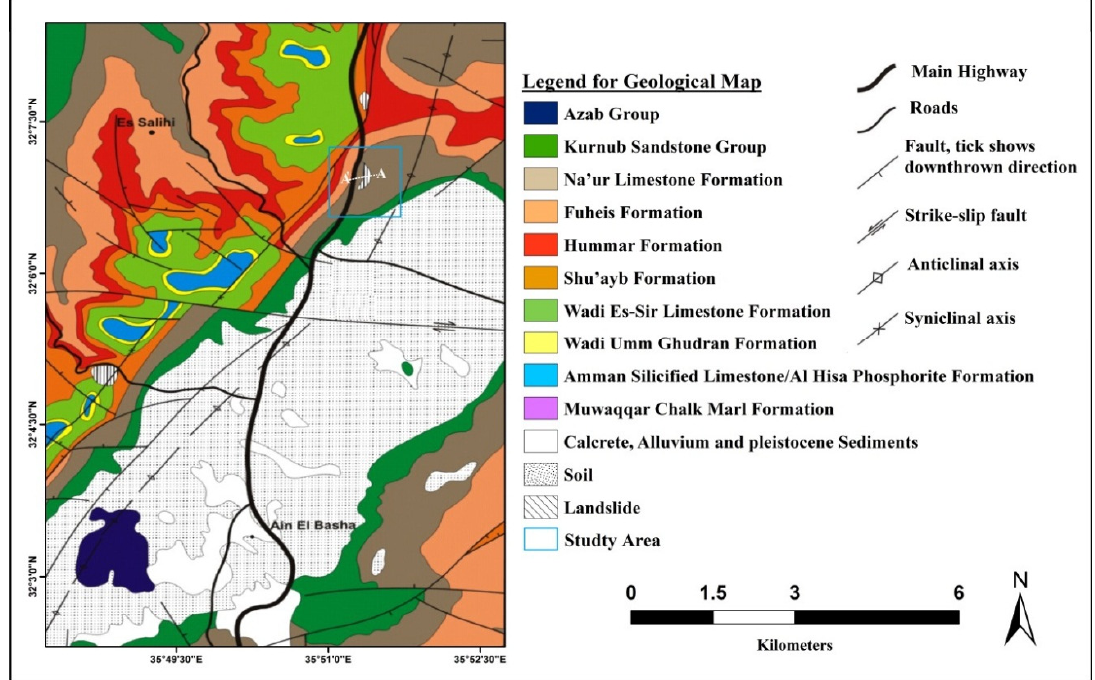
Figure 2. Geological map of the study area (modified after Sawariah and Barjous [73]).